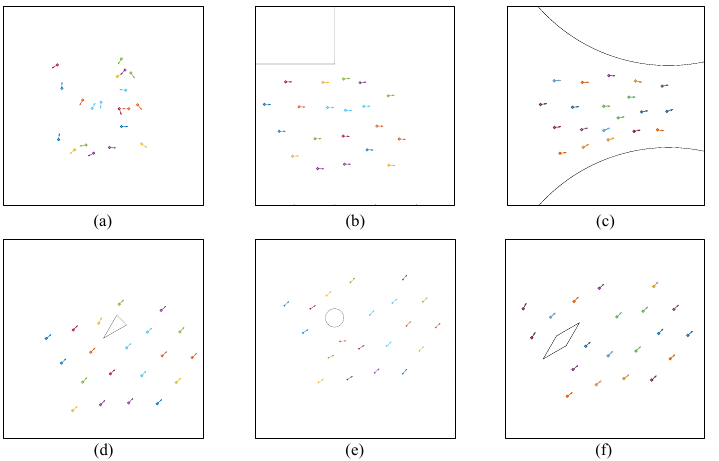
Figure 7. The scene of the system executing the mission. The inset of red dotted line represents the setup of the obstacles. The blue dotted line shows the detail that the individual avoids the obstacle.